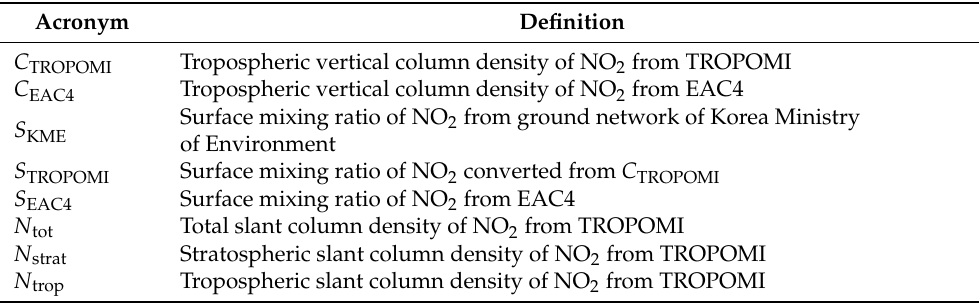
Table 2. Descriptions of different parameters of NO 2 from TROPOMI, surface measurements, and reanalysis data